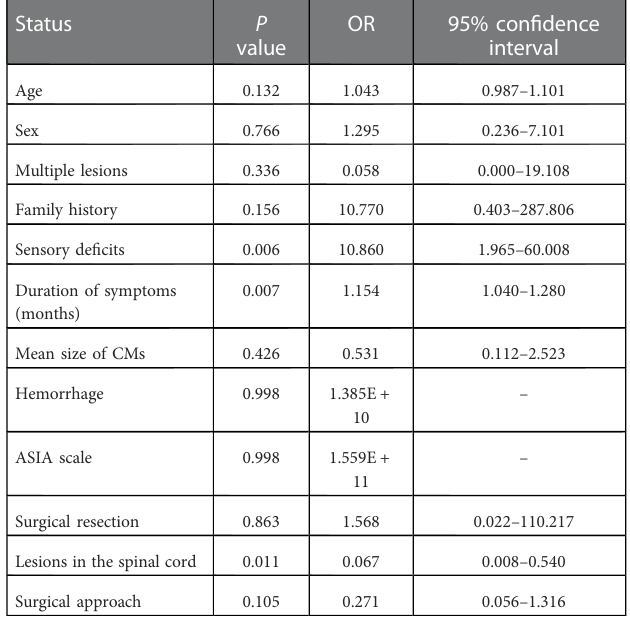
TABLE 5 Multiple logistic regression analysis between improved and unimproved